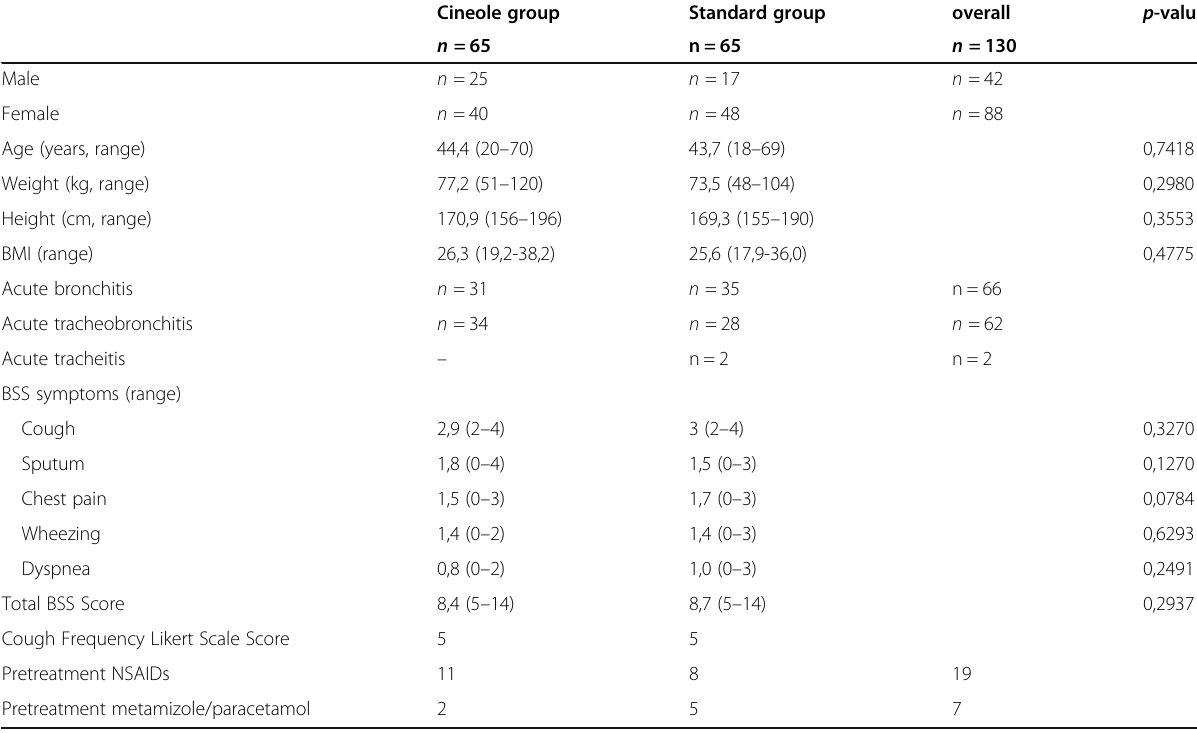
Table 2 Baseline characteristics of included patients (ITT analysis)